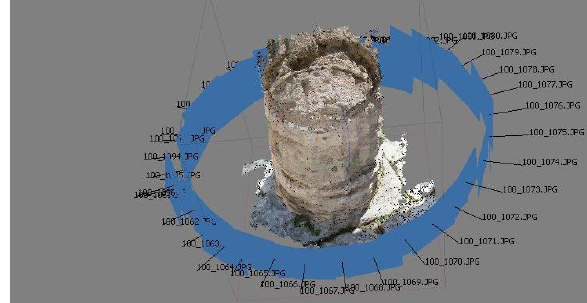
Figure 8. The position of the photos in the model of the column There are certain parameters that control the photo alignment procedure and can be modified in the Align Photos dialog box.